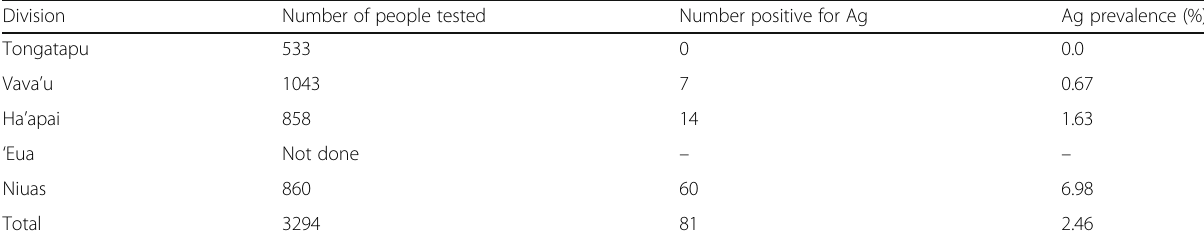
Table 4 Results of mid-term Ag survey in Tonga, 2003 – 2004 Division Number of people